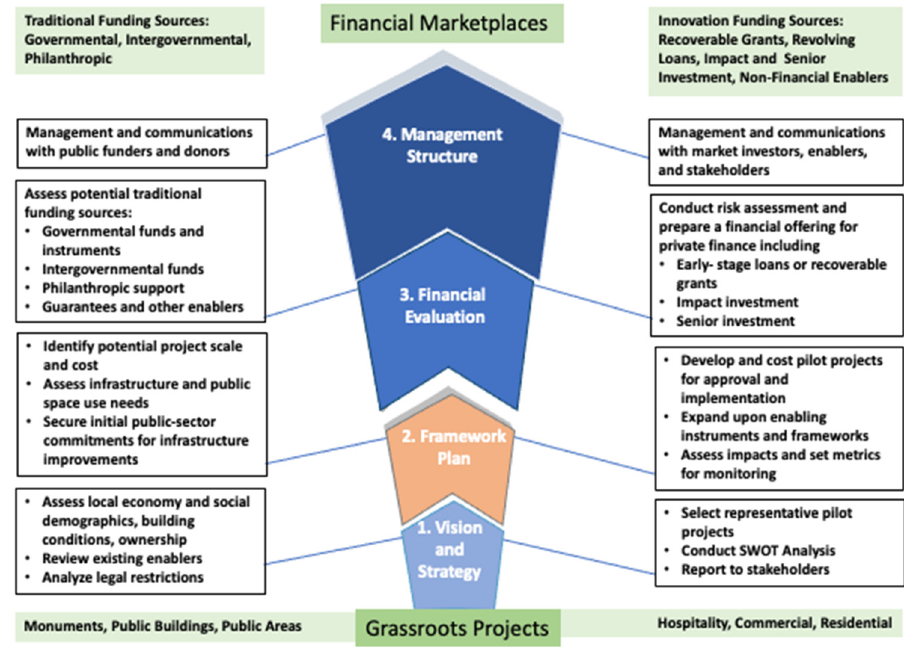
Figure 1. Graphic depiction of the f our-step process for creation of a blended finance strategy .